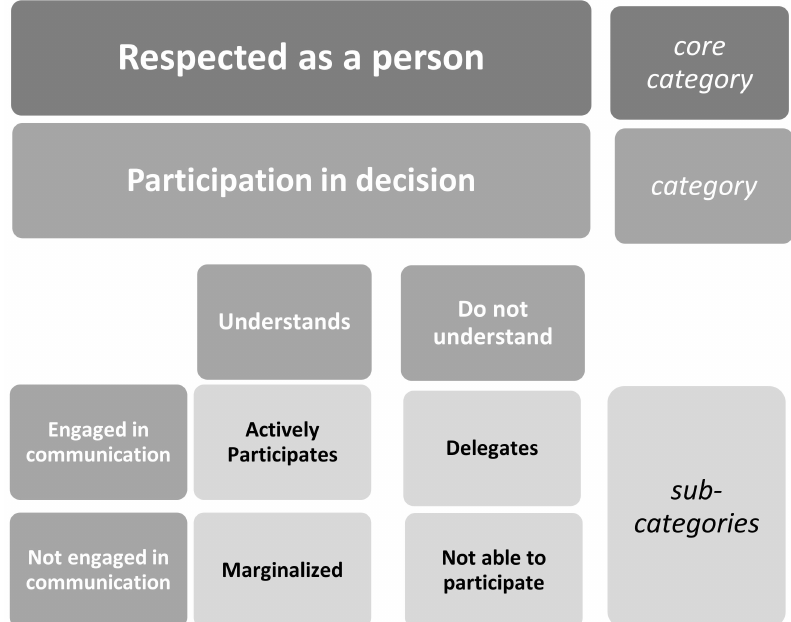
Figure 1. Experiences of receiving a comprehensive geriatric assessment visualized as a hierarchical process where participants felt; “respected as a person” (core category), when participation in decision (category) occurred while engaged in communication and able to understand, leading to four subcategories: actively participates, delegates, not able to participate, and